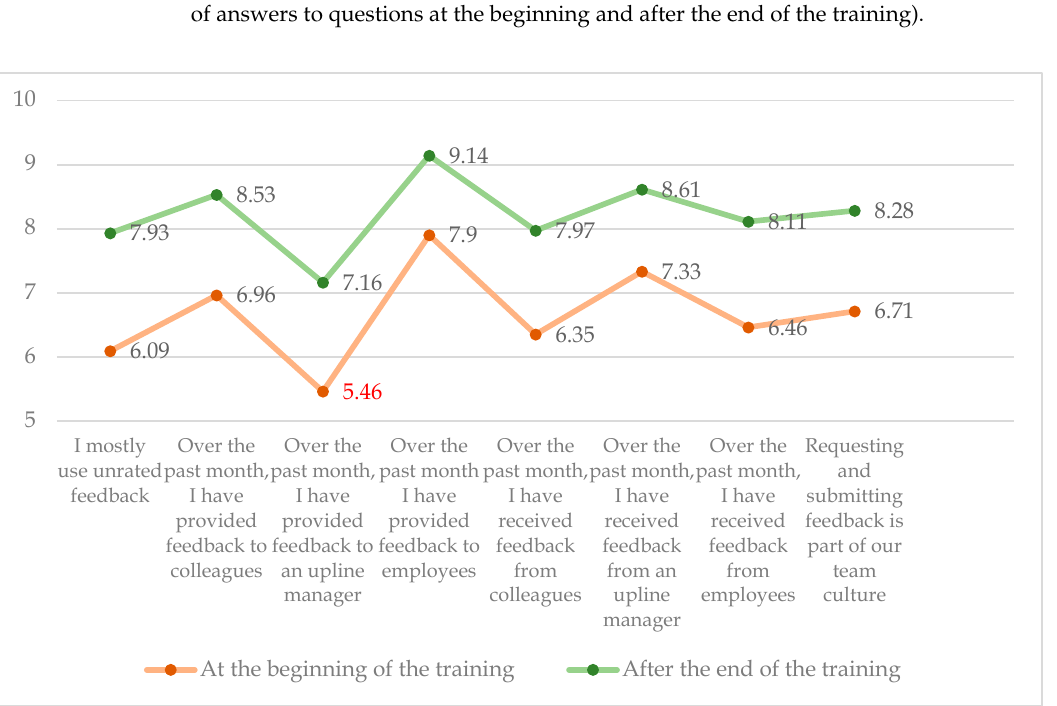
Figure 5. Results of answers to the block of questions “Providing and receiving feedback” (in comparison of answers to questions at the beginning and after the end of the training).